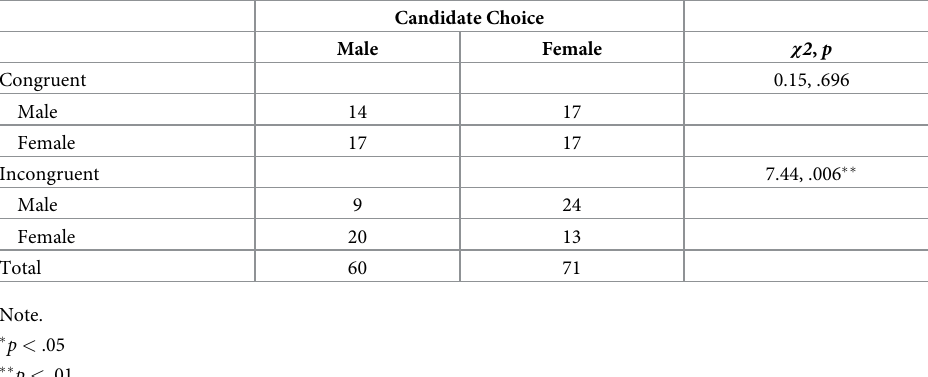
Table 8. Candidate choice by embodiment and participant gender in Study 2.